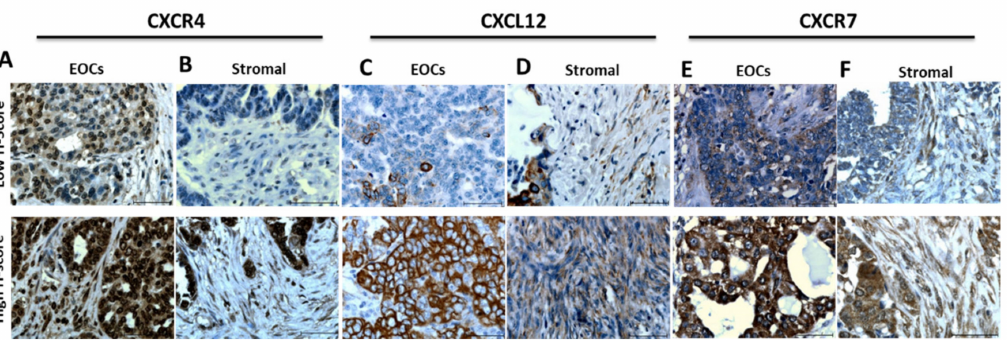
Figure 1. CXCR4-CXCL12-CXCR7 axis is expressed in epithelial and stroma in advanced EOC. CXCR4-CXCL12-CXCR7 expression in epithelial ( A , C , E ) and stromal cells ( B , D , F ) for low (upper panel) and high H-score (lower panel) expression based on best cut-off value for each biomarker component (tumor or stroma) (400 × magnification; bars 50 µ